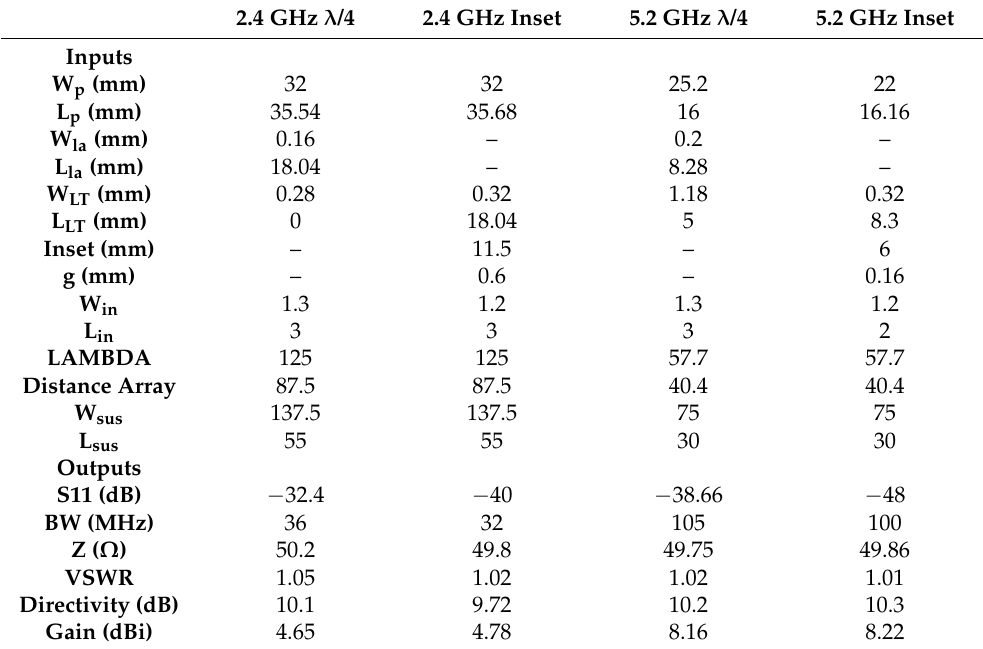
Table 12. Inputs and outputs of the calculated and simulated parameters of the antenna